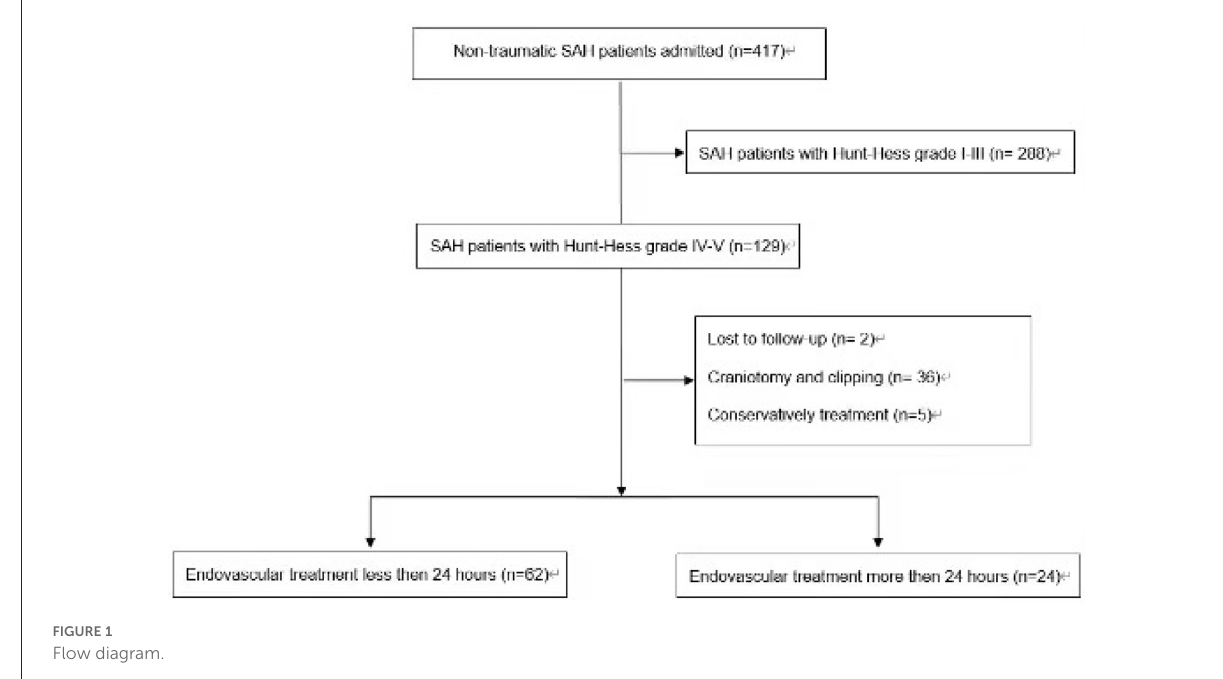
FIGURE1 Flow diagram.